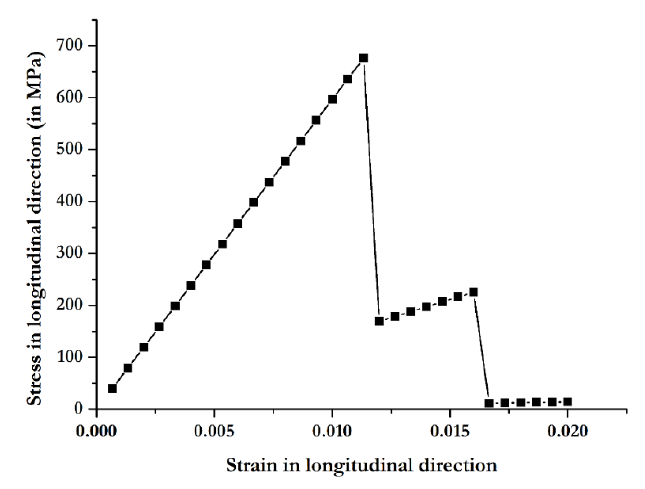
Figure 9. Ply stress distribution computed with Autodesk Helius tool for composite substrate along